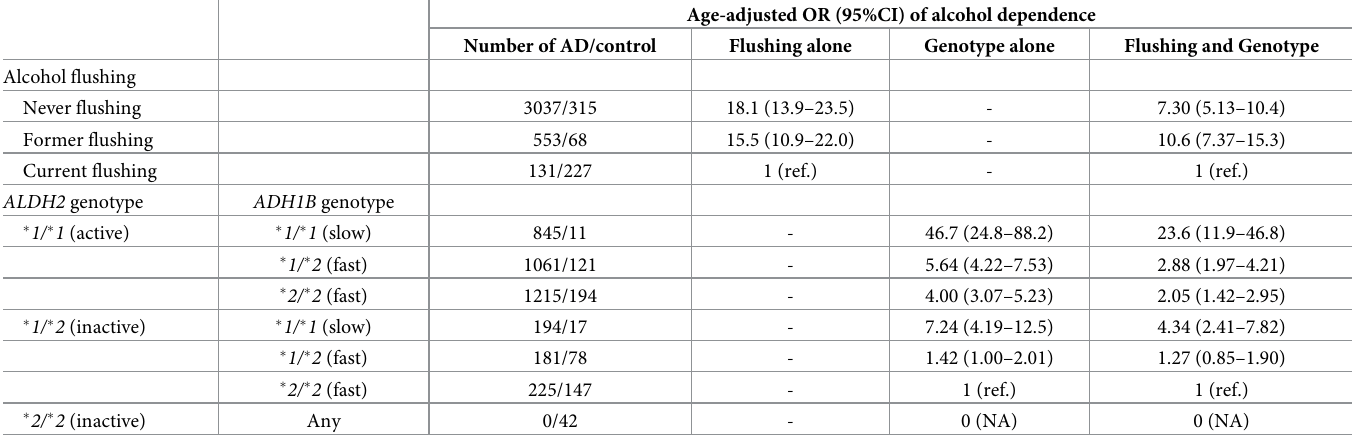
Table 2. Age-adjusted odds ratios (95% confidence intervals) of alcohol dependence according to alcohol flushing status and/or the combinations of ALDH2 and ADH1B genotypes in the male subjects.